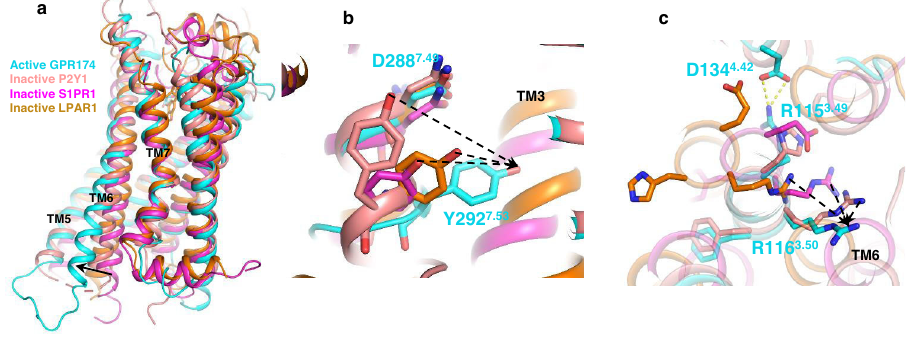
Fig. 4 | Activation of GPR174. a A comparison of active GPR174 with the inactive P2Y1 (PDB: 4xnw), ML056-bound S1PR1 (PDB:3v2y), and ONO-97808307-bound LPAR1 (PDB:4z34). b A comparison of the NPxxY motif between the active